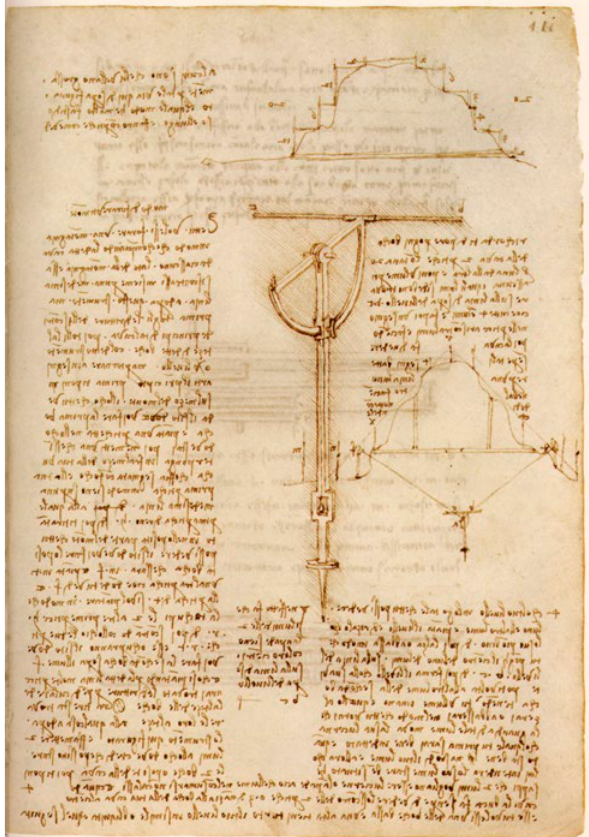
Figure 23. Codex Madrid I, c. 111r: level used to guide the excava- tion of a